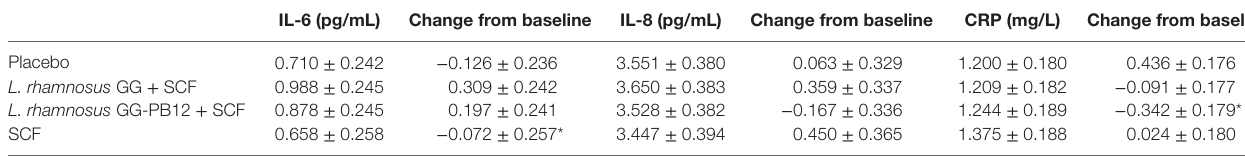
TaBlE 5 | Cytokine production and C-reactive protein (CRP) concentrations expressed in millimolar as change from baseline and 3 weeks intervention study in the active [ Lactobacillus rhamnosus GG + SCF, L. rhamnosus GG-PB12 + Soluble Corn Fiber (SCF), and only SCF] and placebo treatment groups ( n = 37). il-6 (pg/ml) Change from baseline il-8 (pg/ml) Change from baseline CrP (mg/l) Change from baseline Placebo 0.710 ± 0.242 − 0.126 ± 0.236 3.551 ± 0.380 0.063 ± 0.329 1.200 ± 0.180 0.436 ± 0.176 L. rhamnosus GG + SCF 0.988 ± 0.245 0.309 ± 0.242 3.650 ± 0.383 0.359 ± 0.337 1.209 ± 0.182 − 0.091 ± 0.177 L. rhamnosus GG-PB12 + SCF 0.878 ± 0.245 0.197 ± 0.241 3.528 ± 0.382 − 0.167 ± 0.336 1.244 ± 0.189 − 0.342 ± 0.179* SCF 0.658 ± 0.258 − 0.072 ± 0.257* 3.447 ± 0.394 0.450 ± 0.365 1.375 ± 0.188 0.024 ± 0.180 Data shown as means ± SE. *Significantly different from placebo (p < 0.05). Paired t-test.